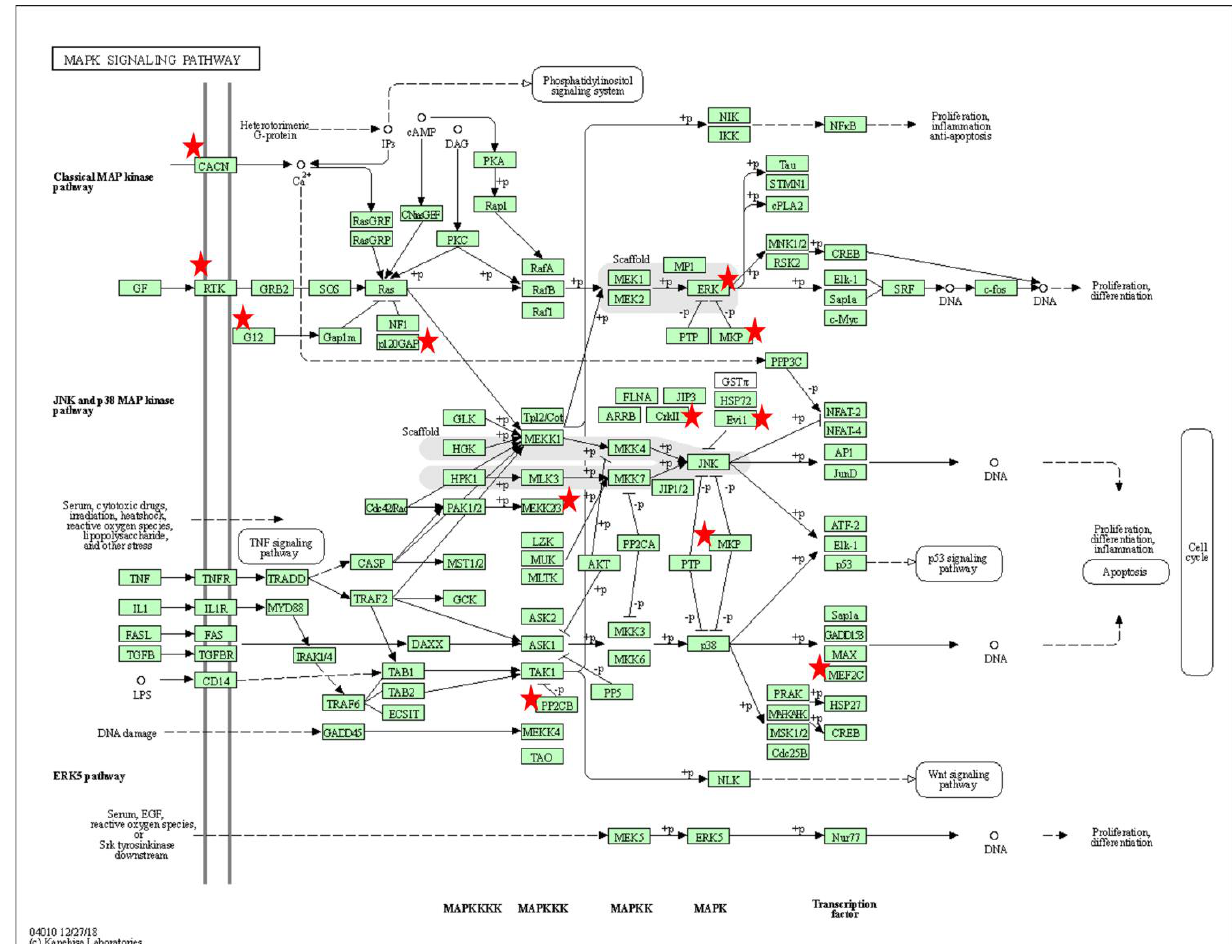
Figure 5. Gene ontology (GO) analysis using the DAVID software. Role of the affected genes (indicated as red stars) within the MAPK signaling pathway associated with